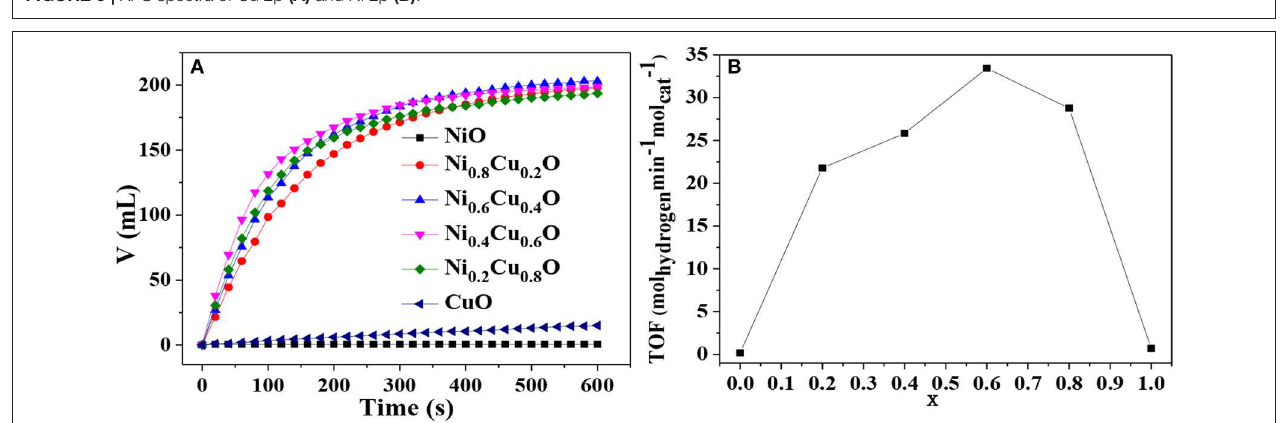
FIGURE 6 | (A) Hydrogen release from AB solution in the presence of different catalyst and (B) TOF values vs. x in Ni x Cu 1 − x O.